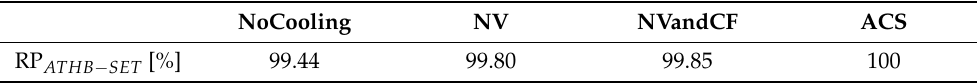
Table 11. Average productivity for each analyzed concept.